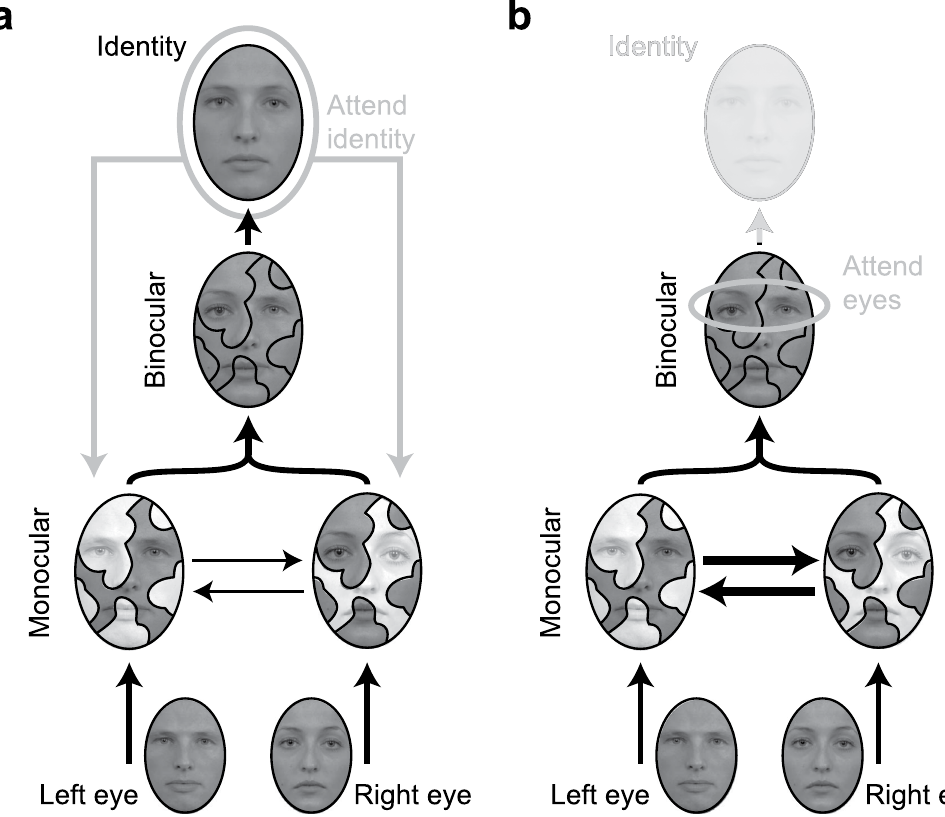
Figure 4. Potential mechanism behind the interocular face stabilization mechanism. ( a ) At a monocular, low level of processing, visual features presented to the individual eyes engage in binocular rivalry. The winning features in each eye (represented here as darker, high contrast areas) combine at a binocular level to form a full face percept. Once a coherent face has been established and higher-level processes have assigned it an identity, feedback back to the early rivalry process may stabilize the competition in favor of its constituent features (thin arrows). ( b ) When attention is directed to face features like eyes, instead of holistic aspects like identity, feedback does not occur and rivalry between face features